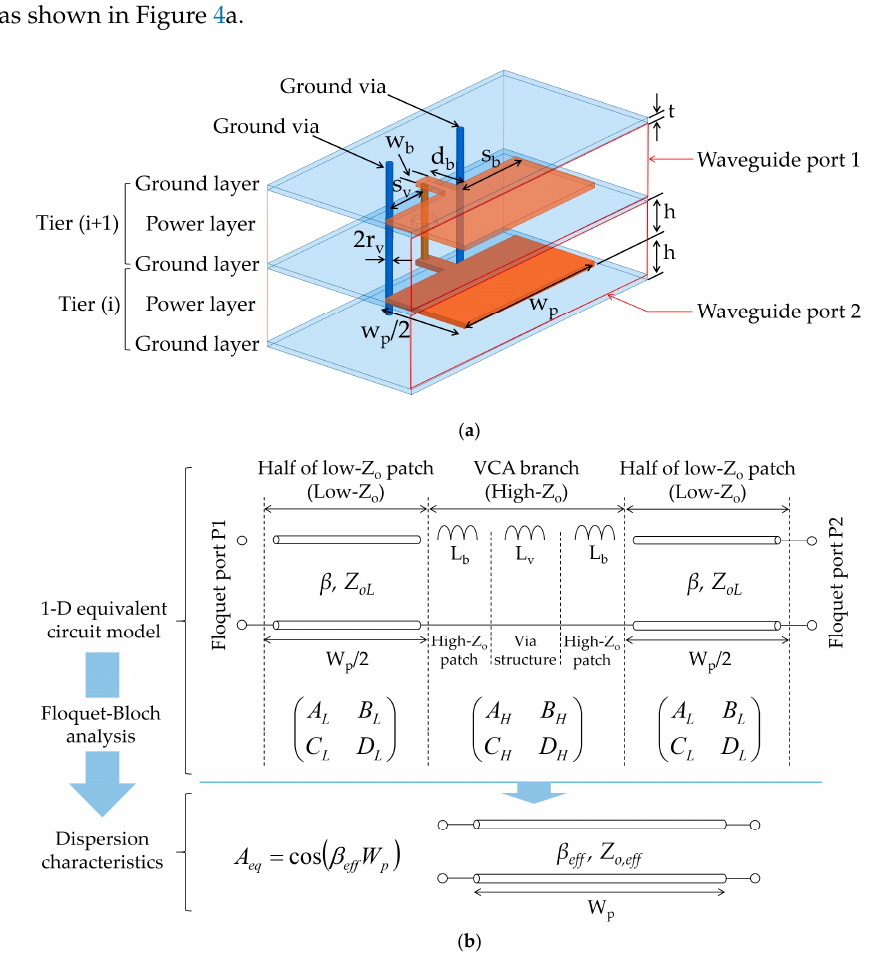
Figure 4. ( a ) A unit cell with design parameters for Floquet-Bloch analysis and ( b ) an equivalent circuit model using a transmission line circuit to extract a dispersion equation.